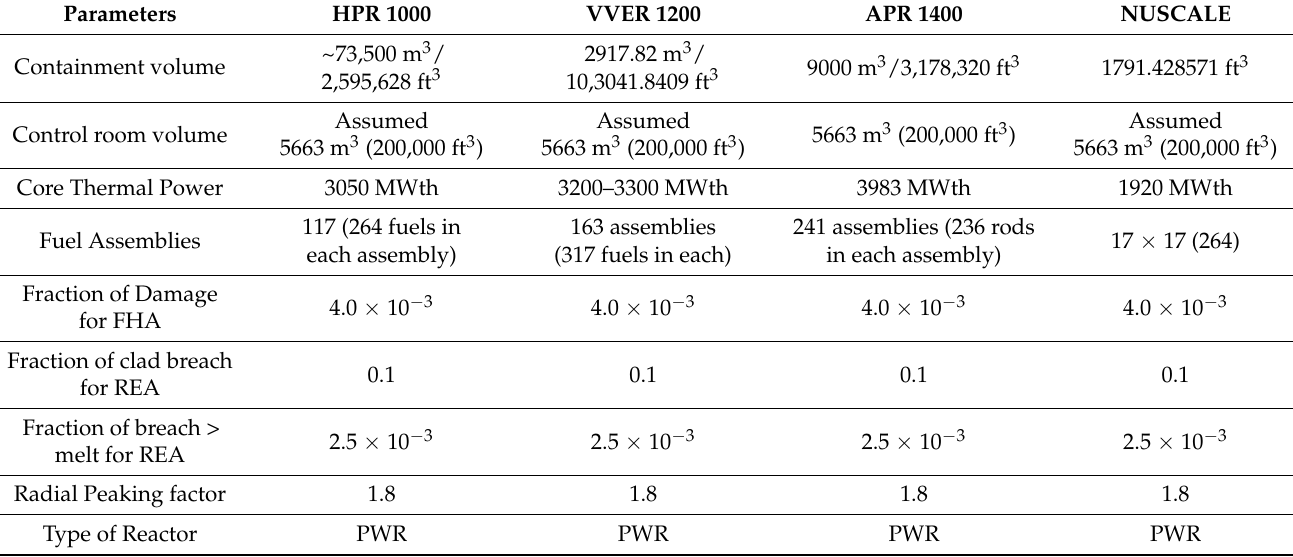
Table 1. Nuclear power plants specific parameters for RADTRAD and RASCAL